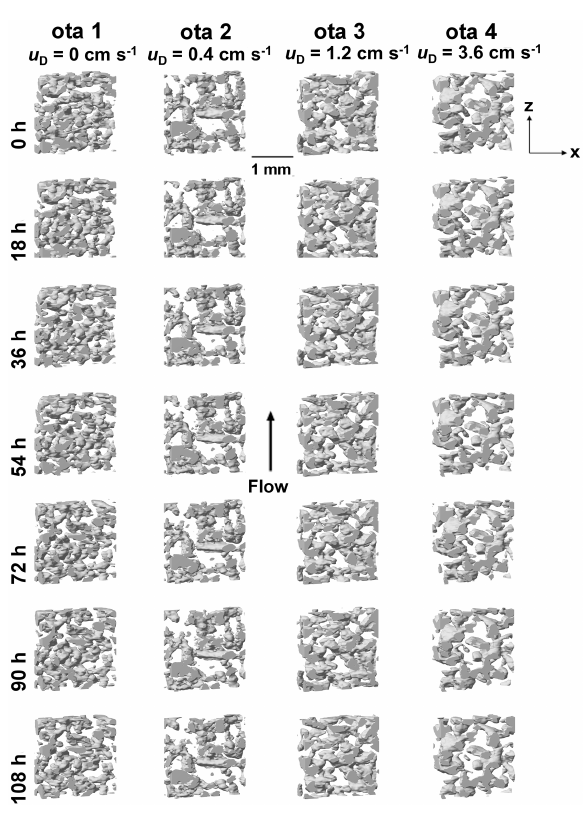
Figure 2. Evolution of the 3-D structure of the ice matrix with ap- plied temperature gradient and advective conditions. Experimen- tal conditions (from left to right) at different measurement times from beginning to the end (top to bottom) of the experiment. The cubes shown are 110 × 40 × 110 voxels (2 × 0.7 × 2mm 3 ) large with 18µm voxel size (a high-resolution figure can be found in the